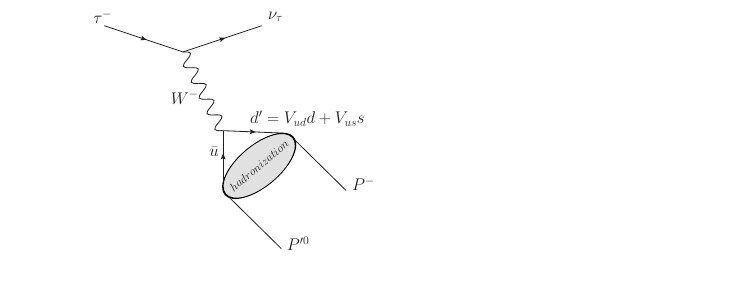
Figure 1. Schematic picture of a tau decaying into two